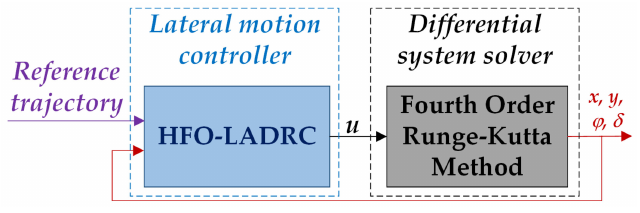
Figure 3. Solving diagram.